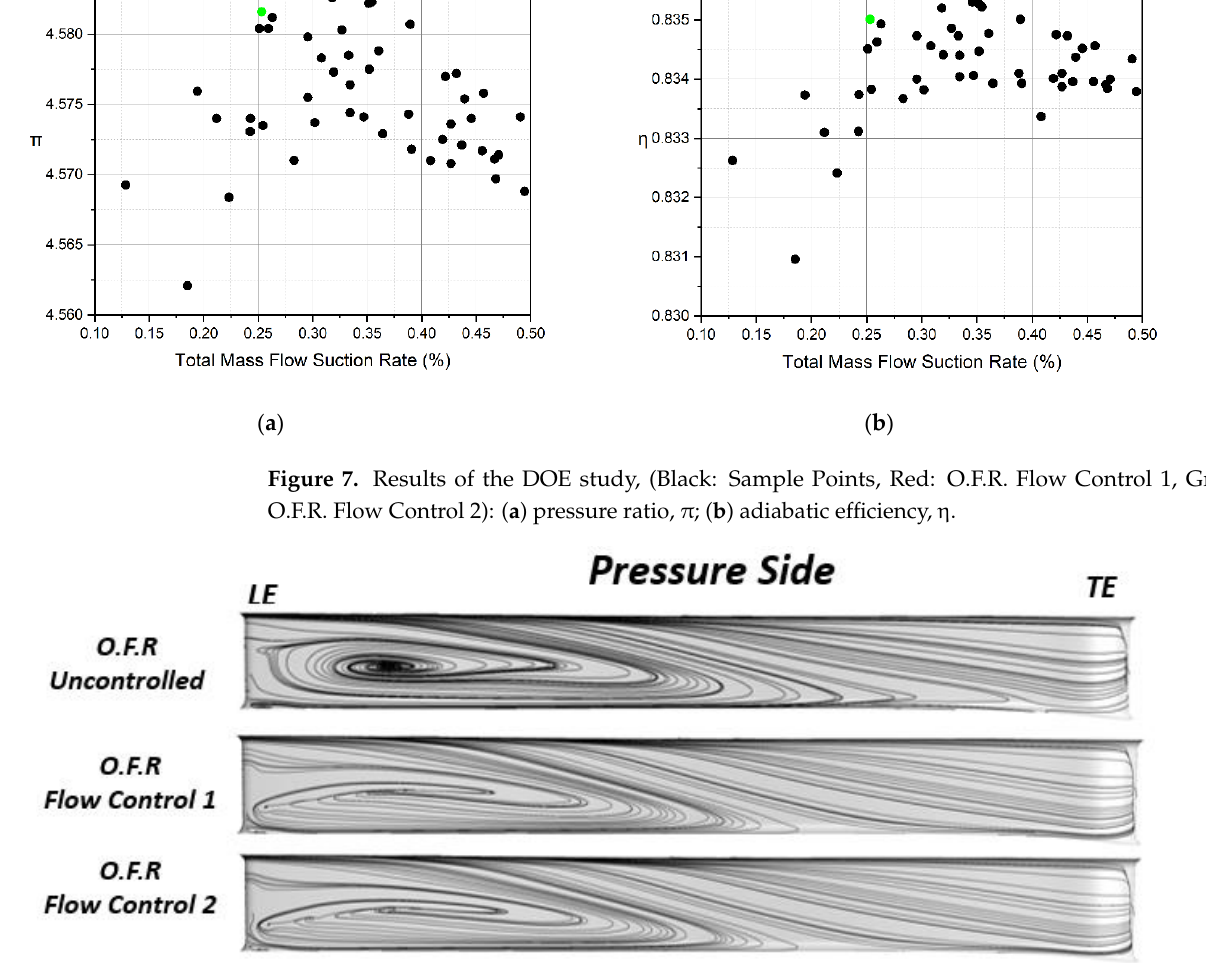
Figure 7. Results of the DOE study, (Blue: Sample Points, Red: O.F.R. Flow Control 1, Green: O.F.R. Flow Control 2): ( a ) pressure ratio, π; ( b ) adiabatic efficiency, η. Table 3. Numeric results of the suction flow control study for operation flow rate.